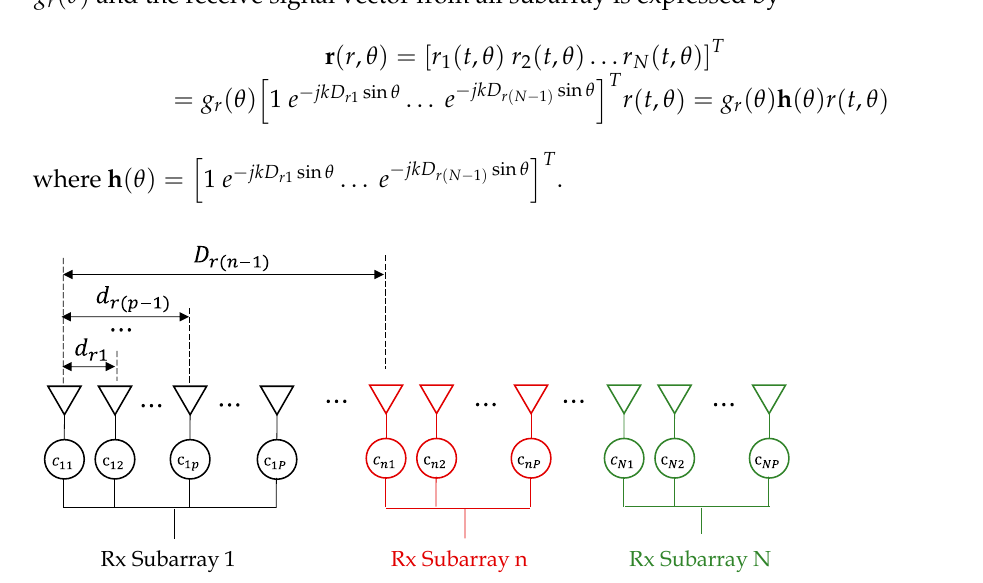
Figure 2. Configuration of the receive antenna with subarrays.